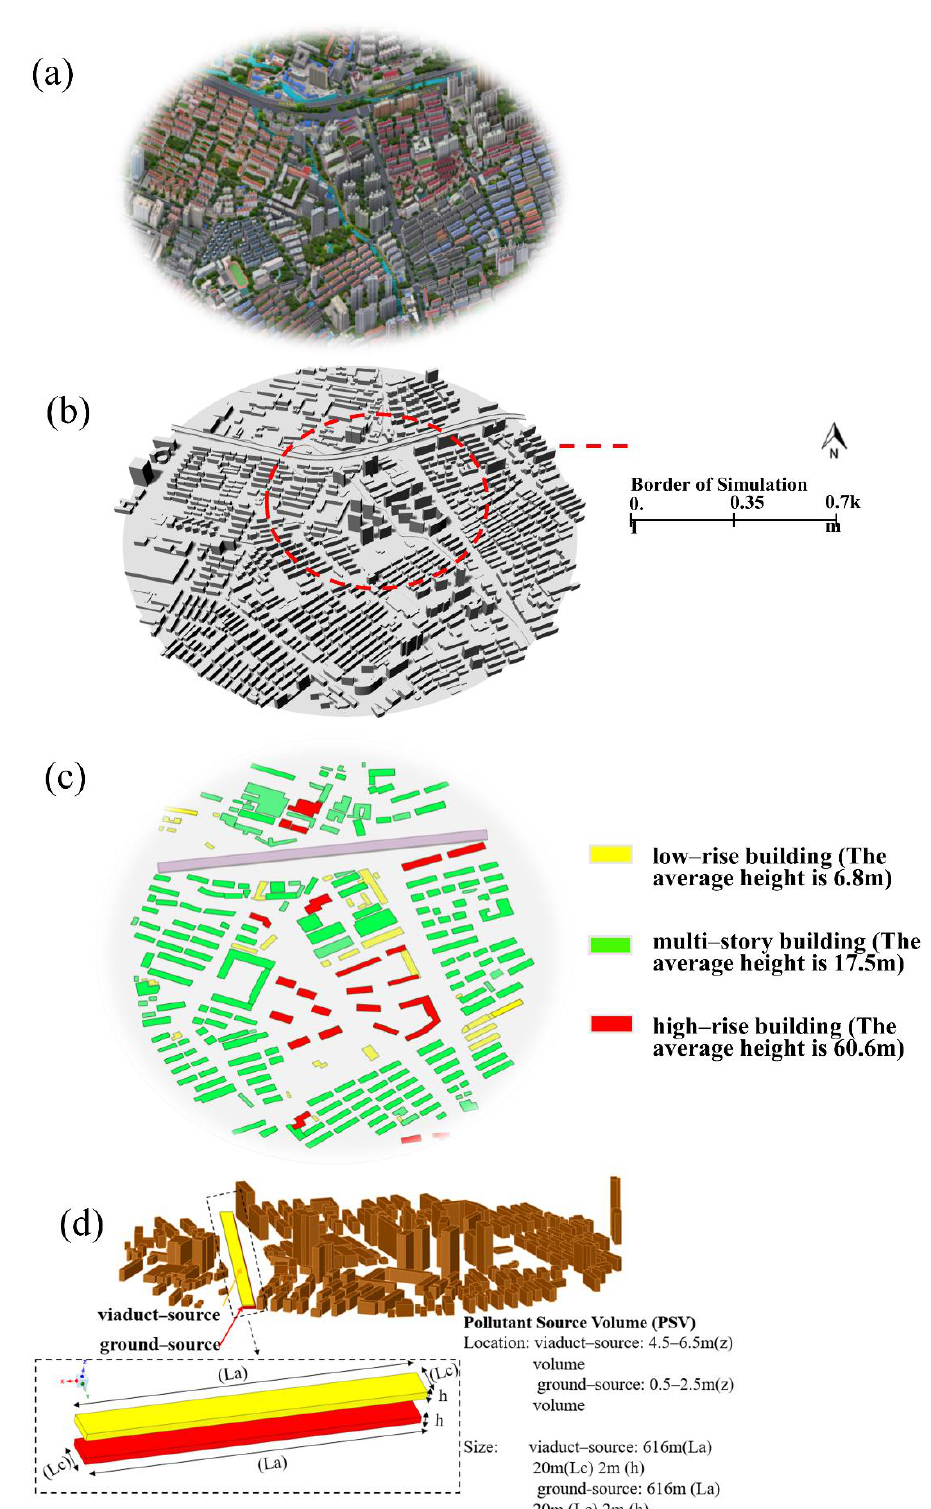
Figure 1. ( a ) Aerial view of target urban area (source: 2.5 wei Maps); ( b ) Corresponding computational geometry; ( c ) Building height classification; ( d ) Pollutant source volume